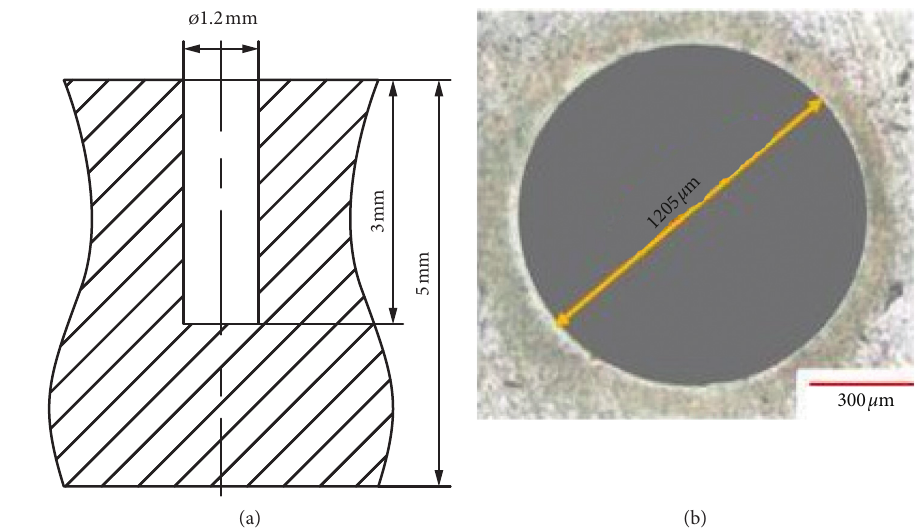
Figure 2: The microdie: (a) sectional view; (b) top view.